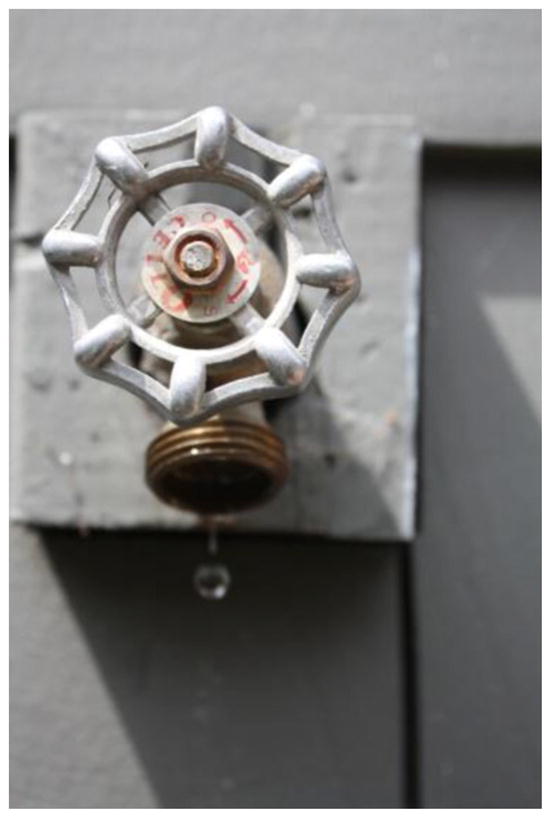
“Turn off the tap”.